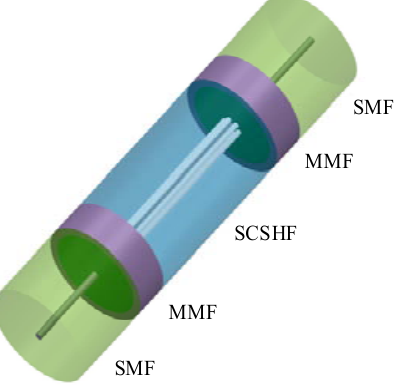
sections of multi − mode fiber (MMF) were fused between SMF and SCSHF. The MMF was